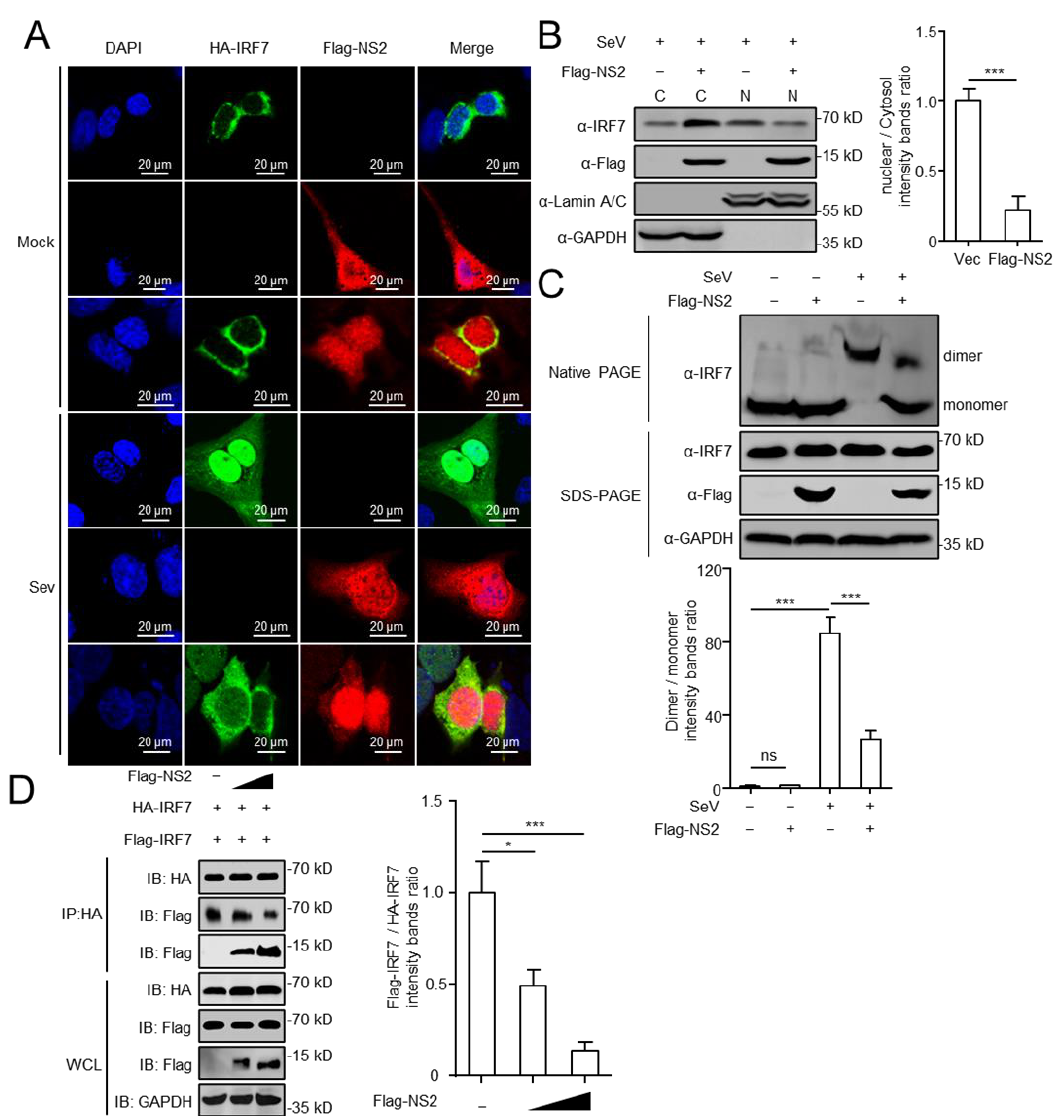
Figure 4. NS2 blocks the nuclear translocation of IRF7. ( A ) U2OS cells were transfected with HA-IRF7 expression plasmid, along with Flag-NS2 or Vec. At twenty hours later, cells were either infected with SeV (4 h) or left untreated. Cells were then stained with rabbit anti-HA and mouse anti-Flag antibodies. Alexa Fluor 488-anti-rabbit immunoglobulin (green) and Alexa Fluor Cy3-anti-mouse immunoglobulin (red) were used as secondary antibodies. Cell nuclei (blue) were stained with DAPI. Scale bar, 20 μm . ( B ) HEK293 cells were transfected with Flag-NS2 or Vec and infected with SeV (4 h) or not. Cell lysates were separated into cytoplasmic and nuclear fractions, and the expression of IRF7 and Flag-NS2 were analyzed by Western blot (fractions: C, purified cytosol; N, purified nucleus). The intensities of the indicated protein bands were determined by using ImageJ (National Institutes of Health, Bethesda, MD, USA), and the ratio of nuclear IRF7 to cytosolic IRF7 was shown in the right panel. ( C ) NS2 suppressed IRF7 dimerization. HEK293 cells were transfected with Flag-NS2 or Vec, and treated with SeV for another 4 h. Native PAGE assays were performed to detect IRF7 dimerization. SDS PAGE assay were performed to detect IRF7, Flag-NS2, and GAPDH. The